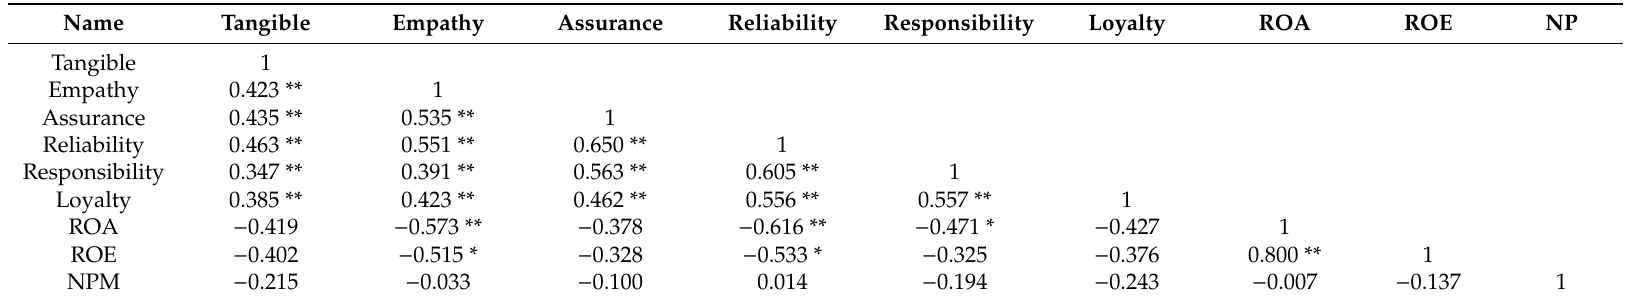
Table 5. Pearson Correlation Matrix.